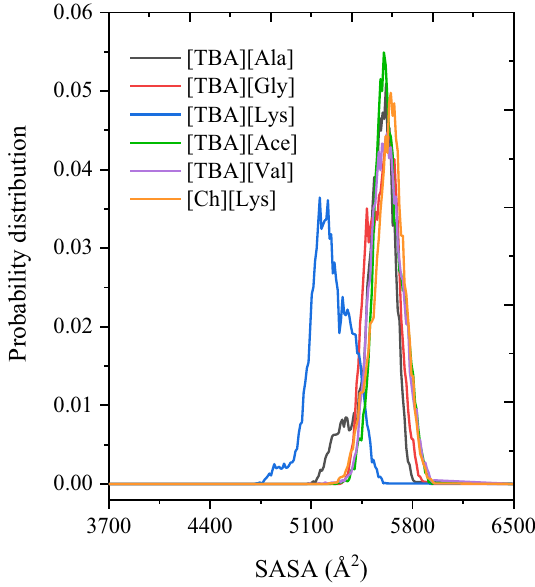
Figure 9. The probability distribution of SASA for the lignin polymer in ionic liquids.